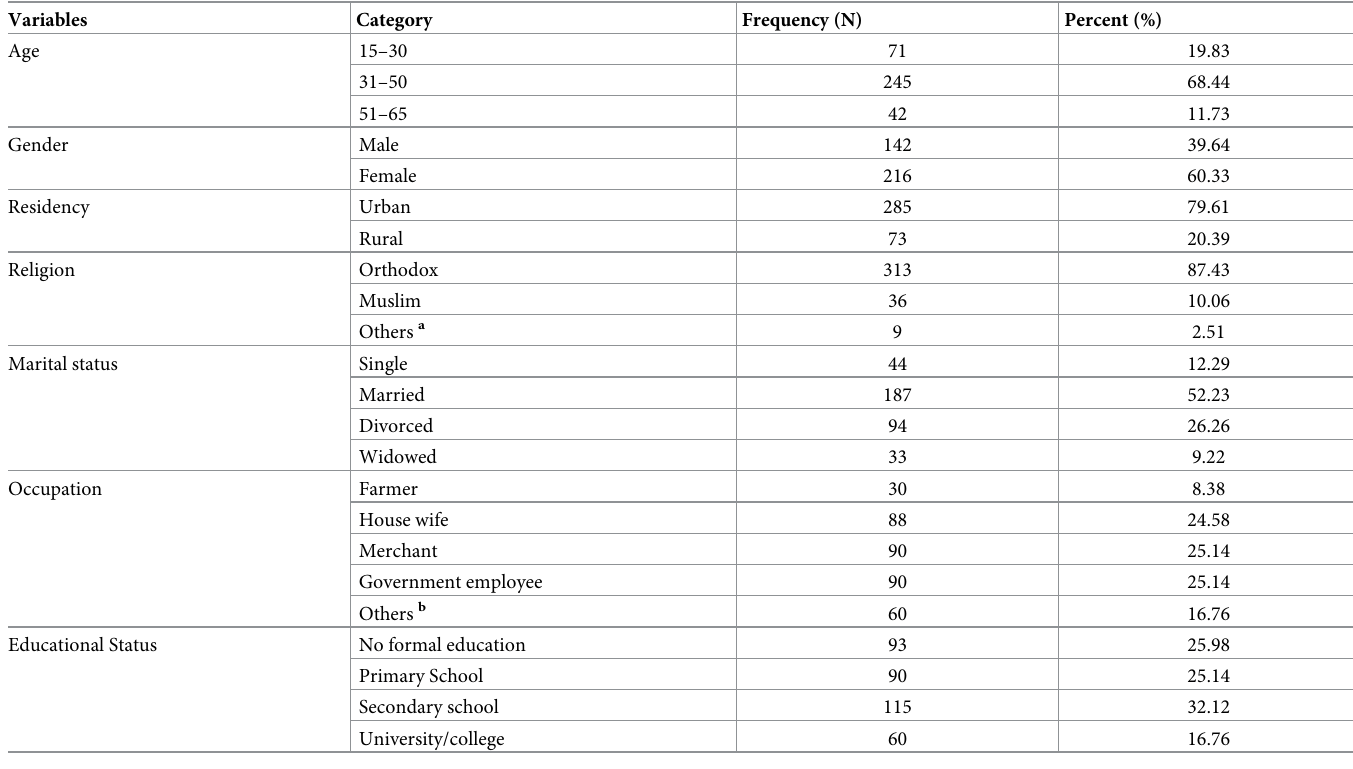
Table 1. Sociodemographic characters of study participants for the magnitude of IHA and associated factors among HIV infected adults at UOGCSH March to April 2021 (N = 358).